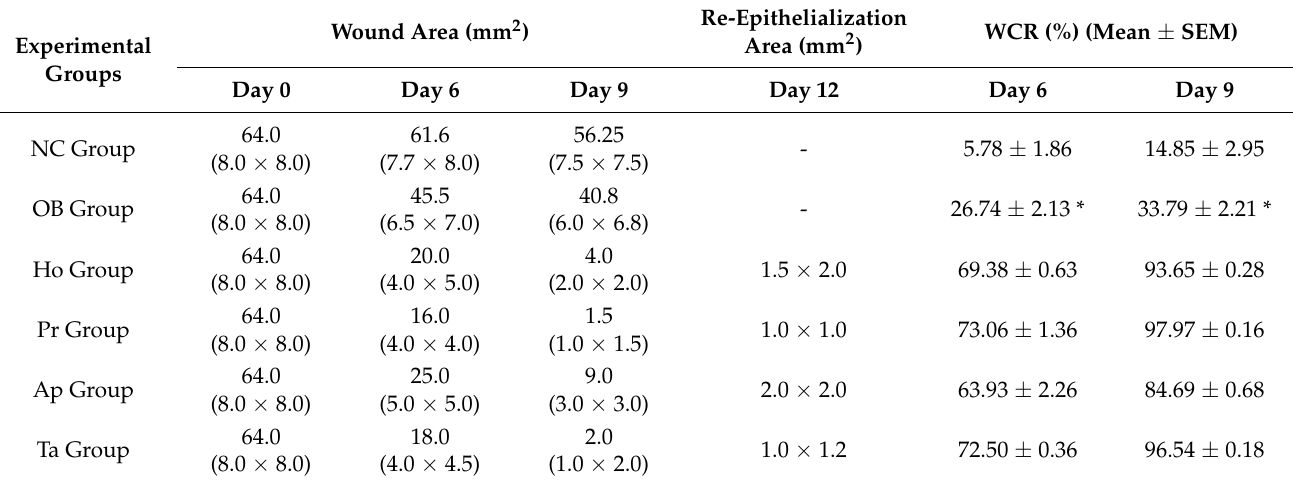
Table 2. Evaluation of wound area, re-epithelialization area and wound contraction rate (WCR) for the excision model.